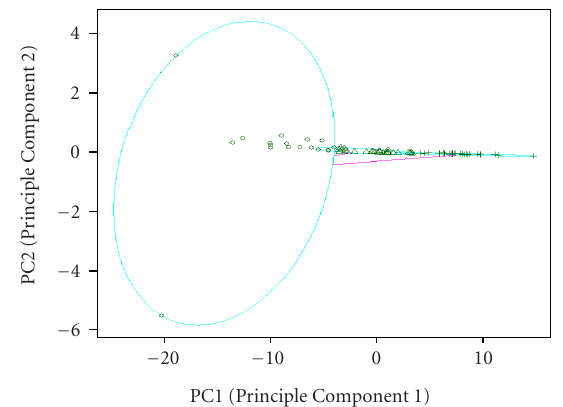
Figure 8. The δ B dissimilarity approach with